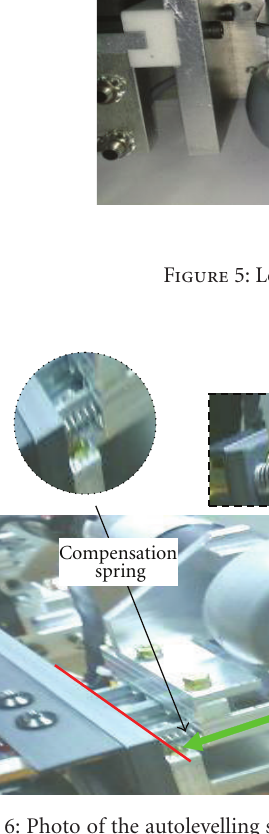
Figure 6: Photo of the autolevelling system, with the sliding guide and spring compensated